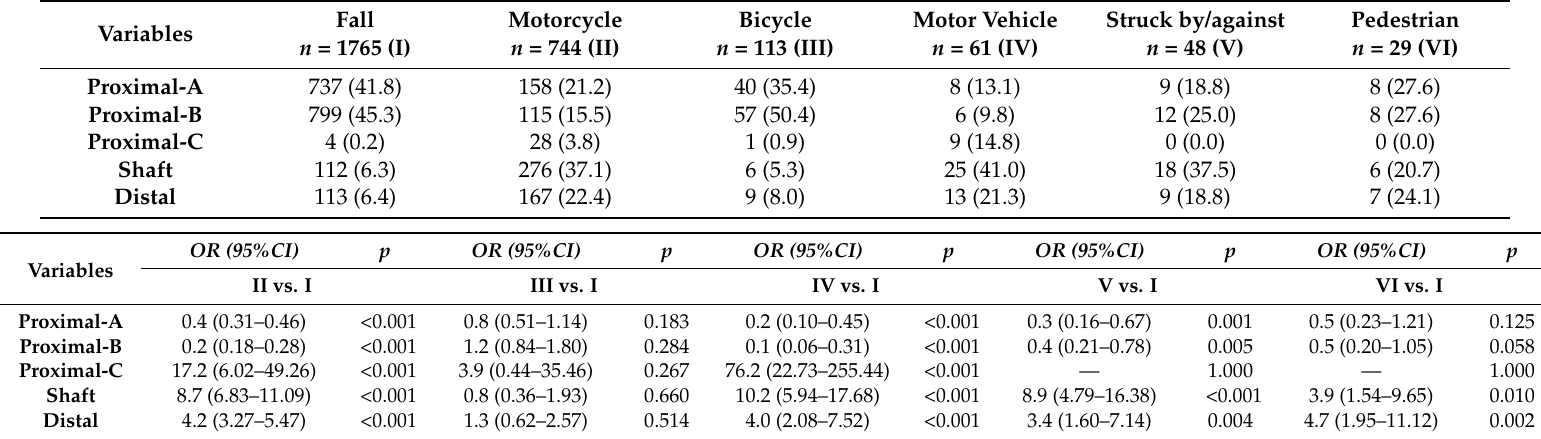
Table 2. Location of femoral fracture in patients with different injury mechanisms.